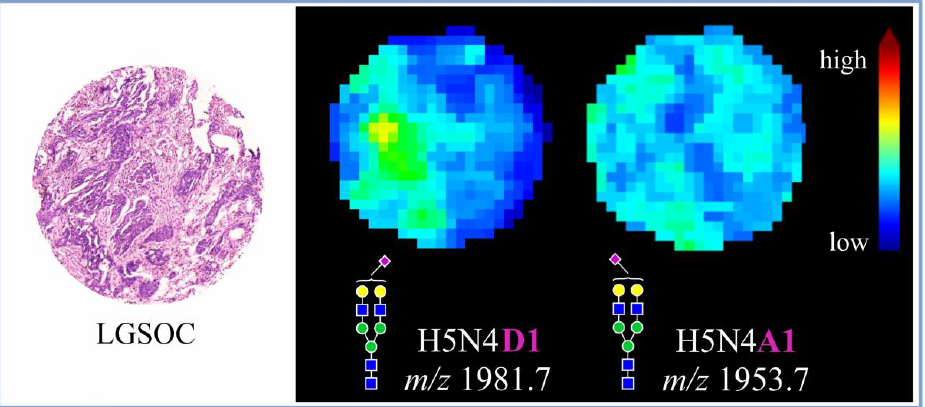
Figure 3. Spatial distribution of two differently sialylated N -glycan structures in an exemplary LGSOC tissue core as determined by MALDI-MSI.